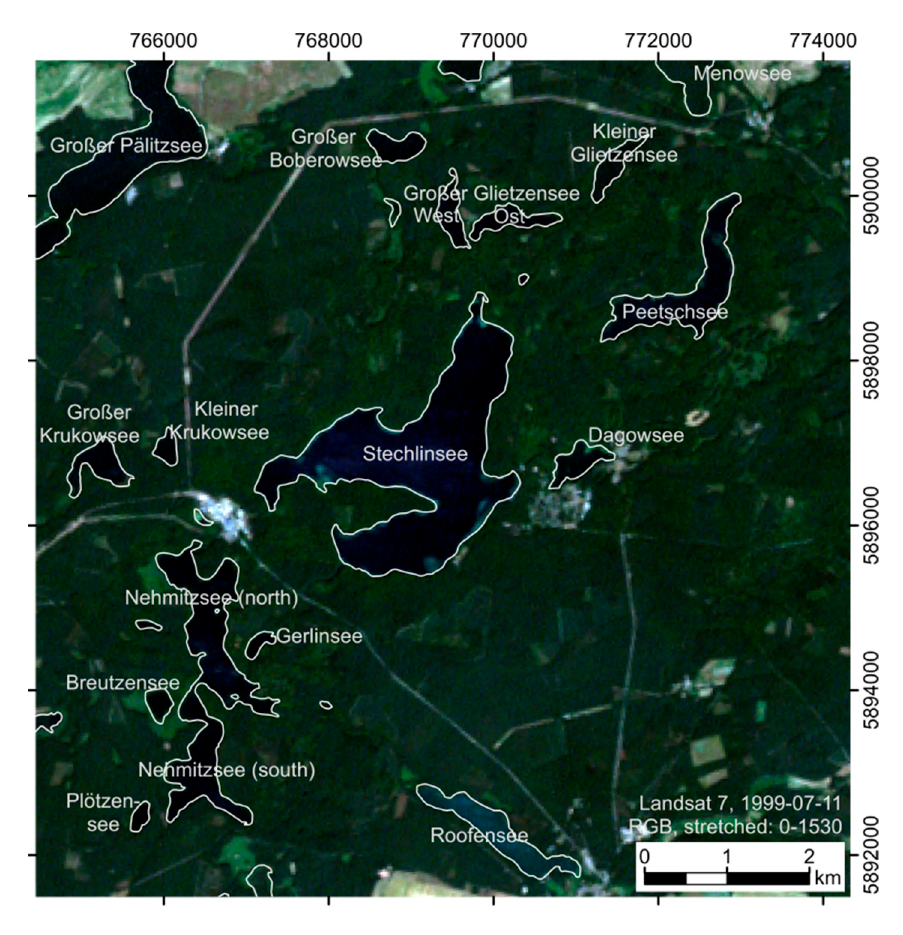
Figure 4. Study area of the Rheinsberg Lake Region on 11 July 1999 (Landsat 7, quasi-true color RGB). All lakes appear dark and are framed with white lines.